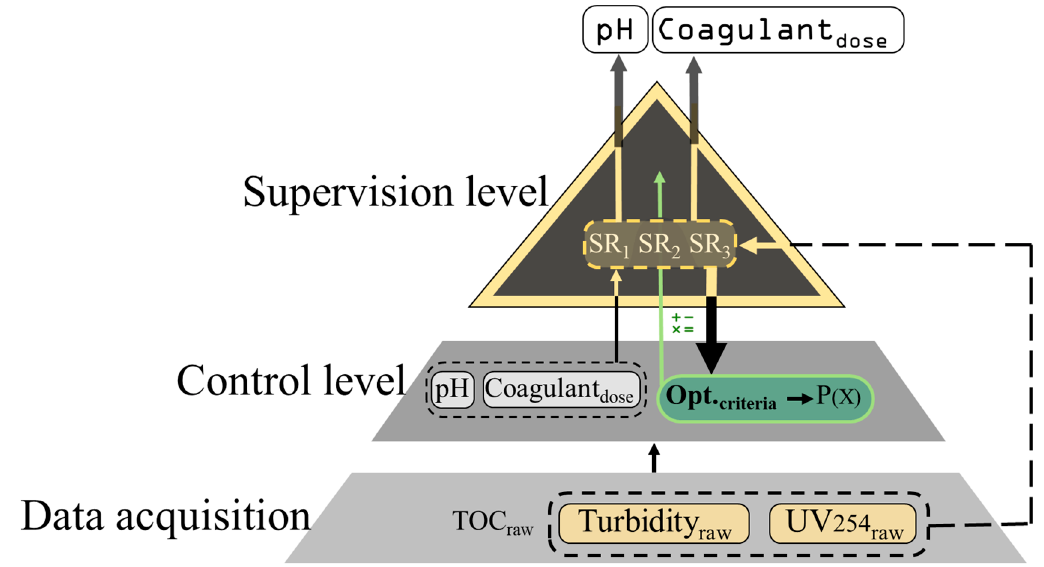
Figure 8. Architecture proposed for enhanced coagulation environmental decision support system (EDSS).